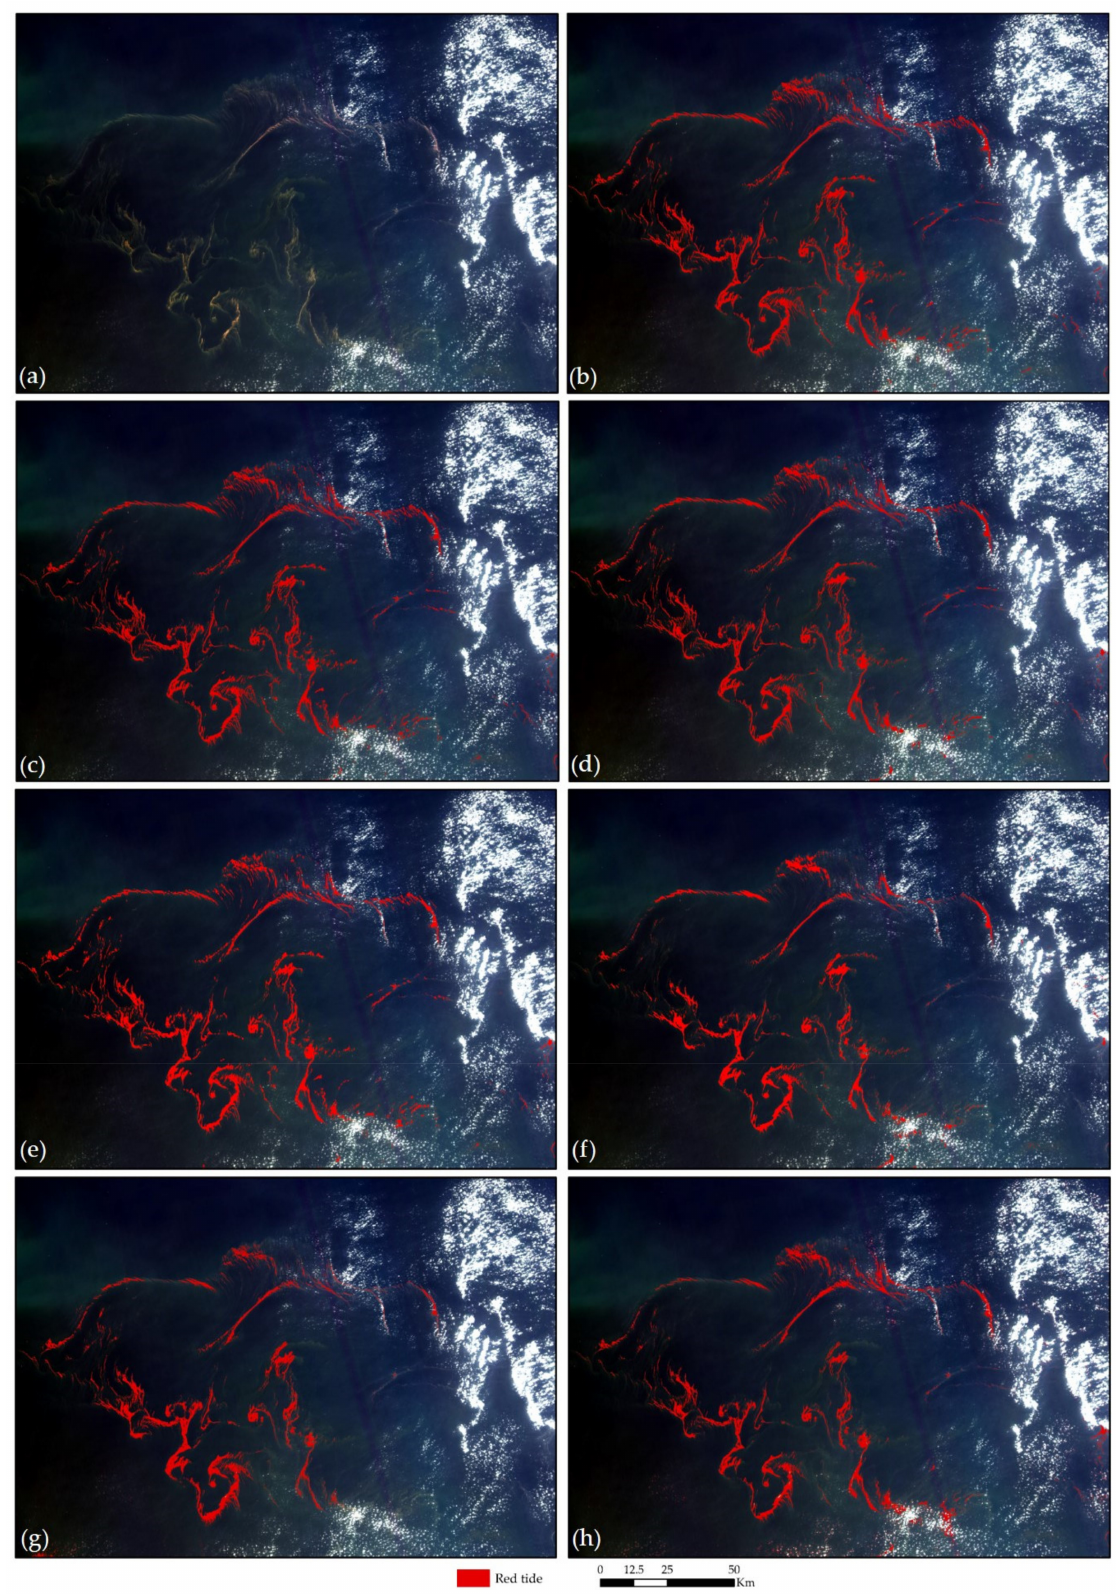
Figure 7. Red tide detection results based on different methods. ( a ) HY − 1D; ( b ) Validation map; ( c ) RDU − Net; ( d ) U − Net; ( e ) FCN − 8s; ( f ) SegNet; ( g ) SVM; ( h ) GF1_RI. The red regions represent red